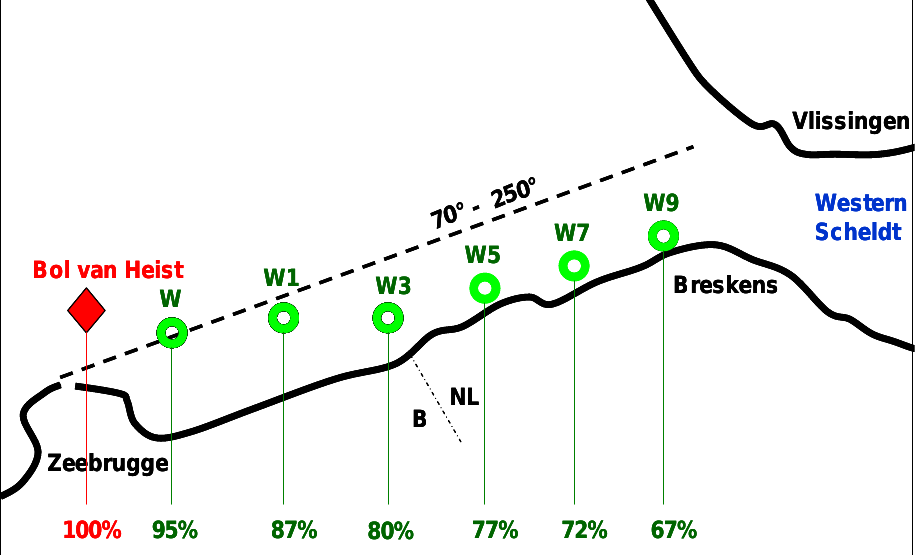
Figure 10. Wave climate variations between Zeebrugge and the Western Scheldt (based on De Beck, 2007). Even if a rather restricted coastal area is considered, the wave climate may be spatially